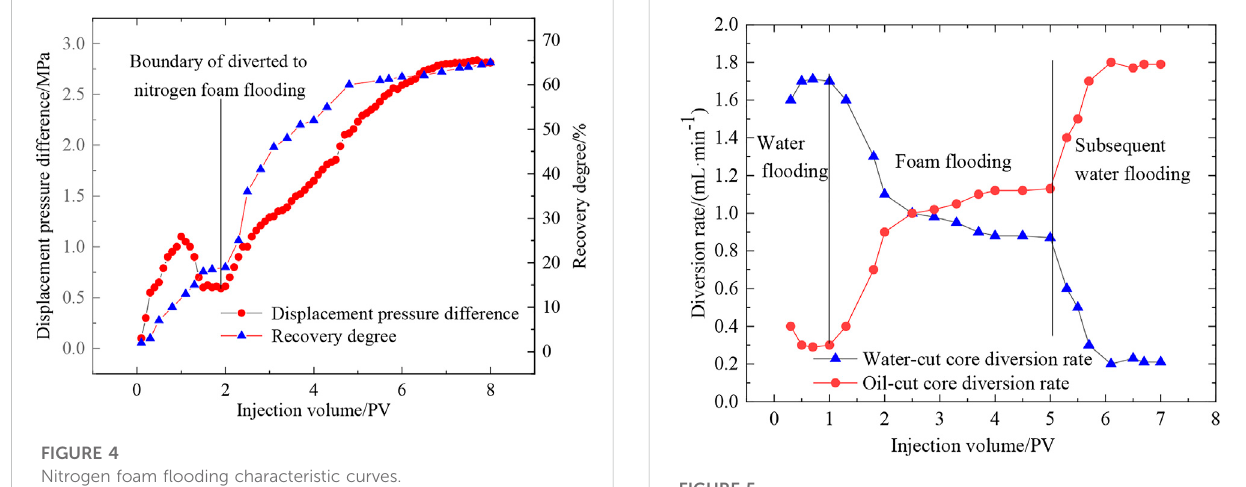
FIGURE 5 Experimental results of the parallel fl ow of core